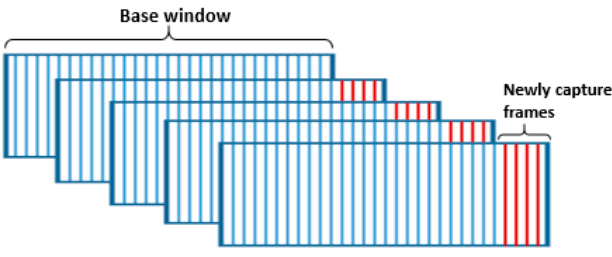
Figure 5. Overlapping windows processing framework.